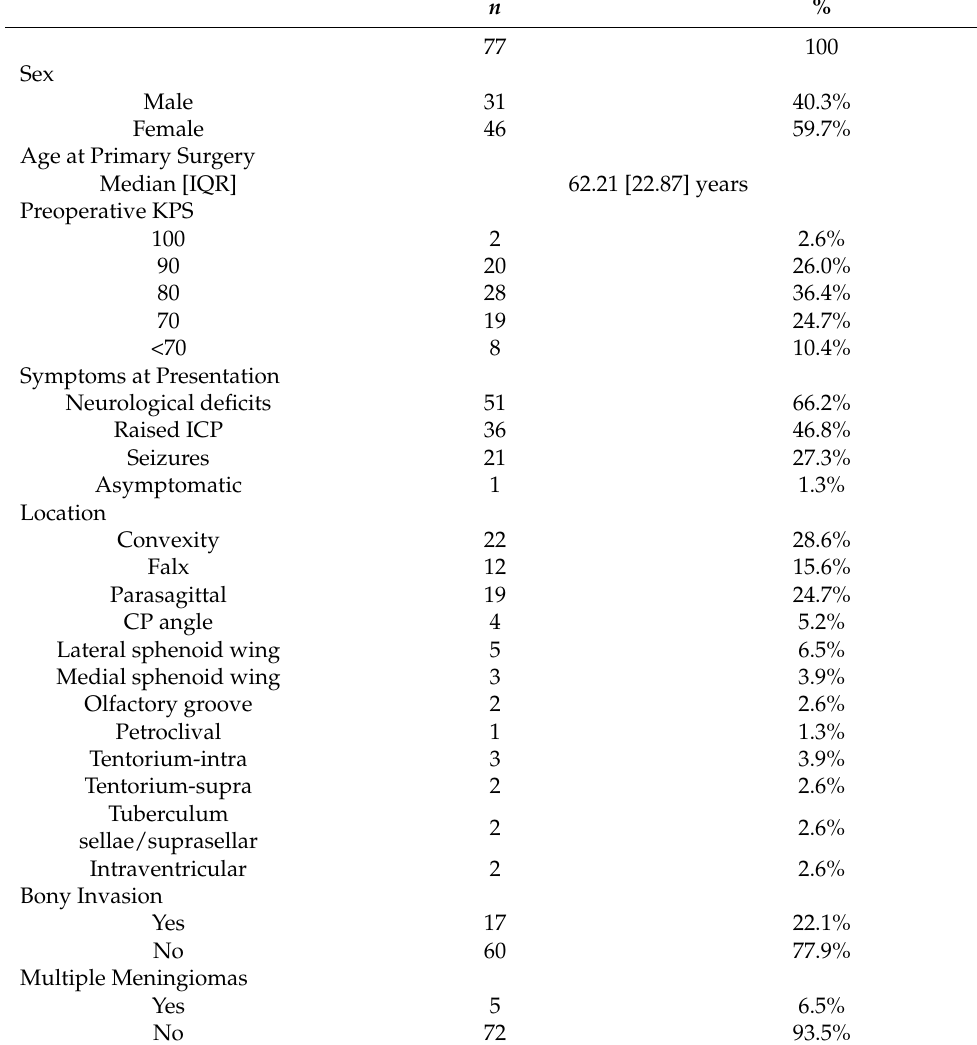
Table 1. Overall characteristics of patients involved in the